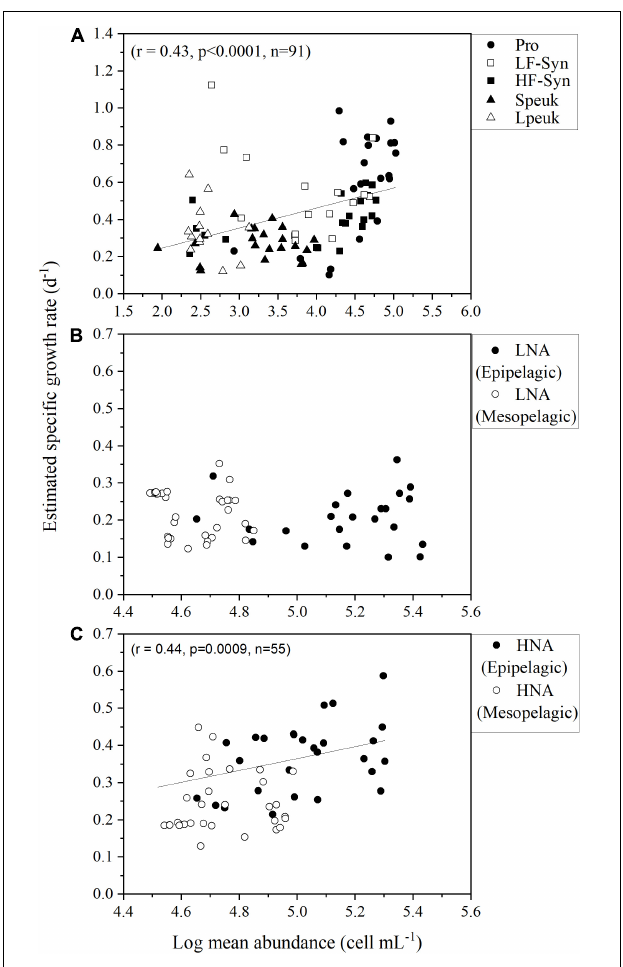
FIGURE 8 | Relationships between the mean diel abundance of (A) autotrophic picoplankton and (B,C) HNA and LNA heterotrophic prokaryotes in the epipelagic and mesopelagic layers, excluding the second-noon to avoid duplicate data, and the estimated specific growth rate. Group abbreviations as in Figure 4